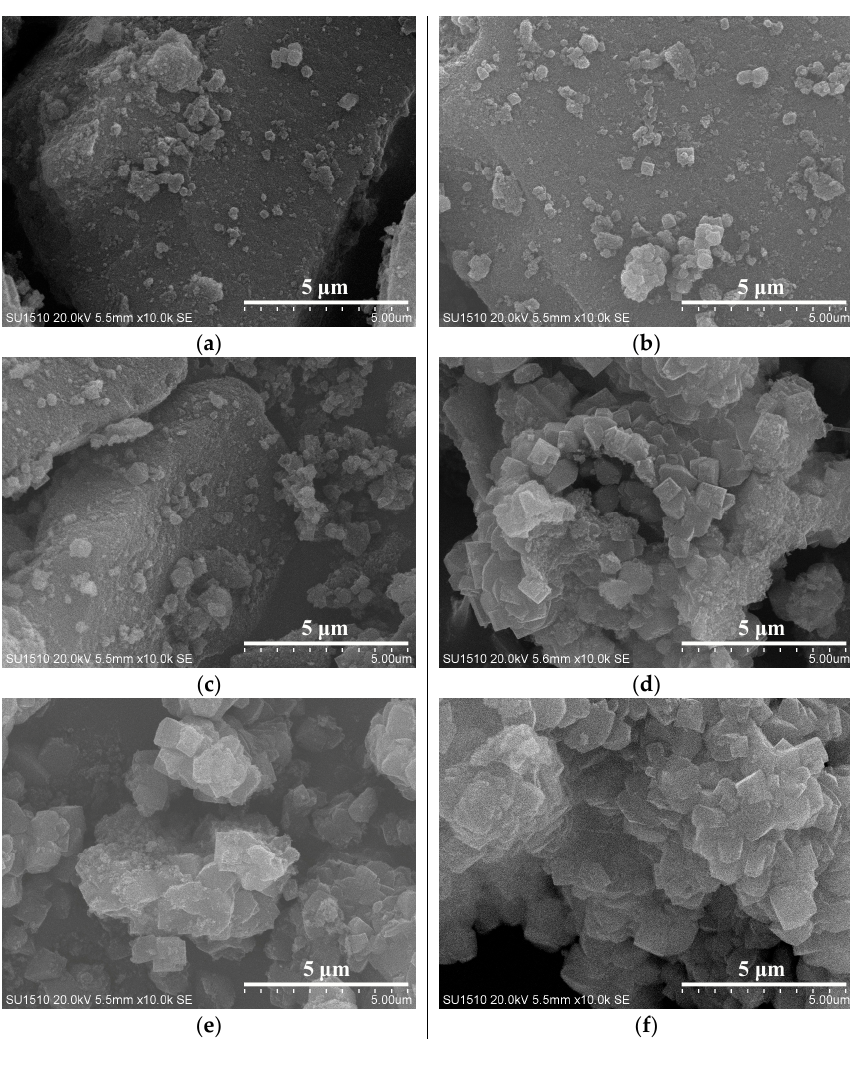
Figure 8. SEM images of S-Beta samples crystallized for ( a ) 0; ( b ) 6; ( c ) 18; ( d ) 36; ( e ) 48 and ( f ) 60 h, respectively.